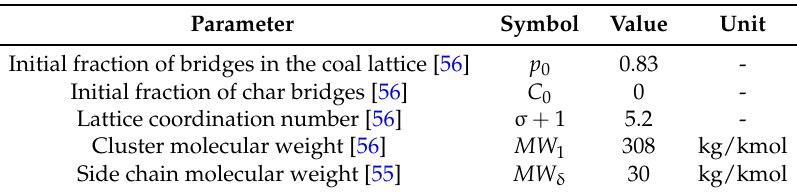
Table 5. Coal-specific parameters for the CPD model.